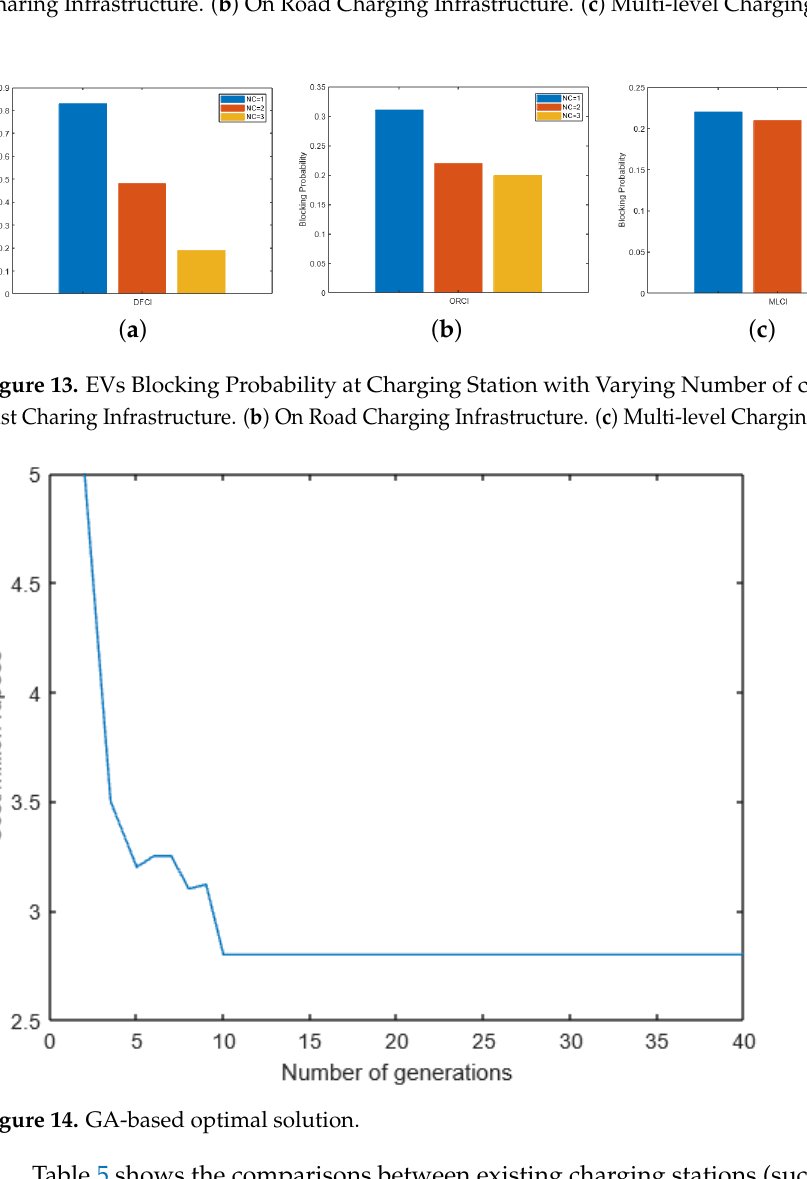
Figure 12. EVs Blocking Probability at Charging Station with Varying Service Rates. ( a ) DC Fast Charing Infrastructure. ( b ) On Road Charging Infrastructure. ( c ) Multi-level Charging Infrastructure.